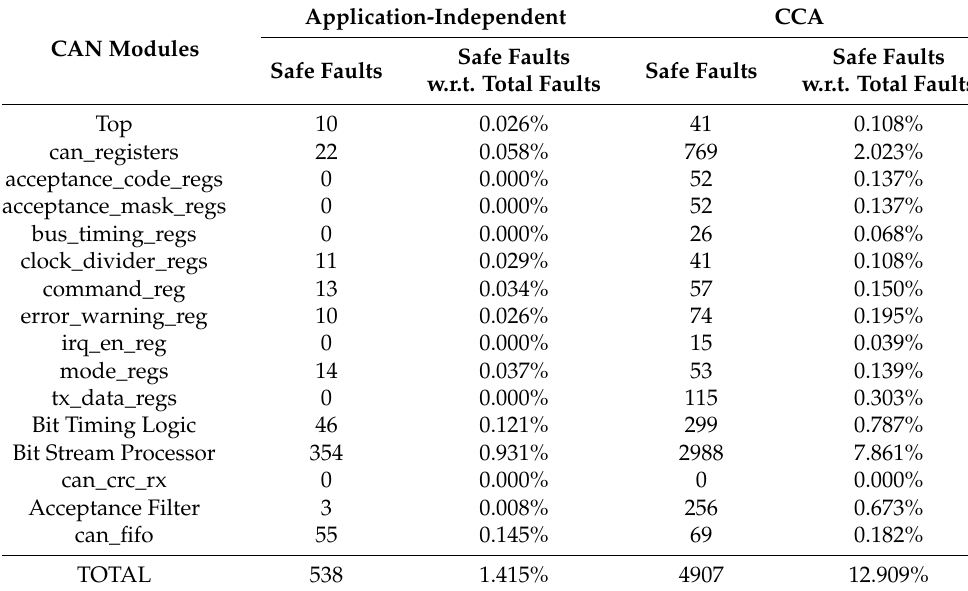
Table 4. Safe faults in the CAN controller